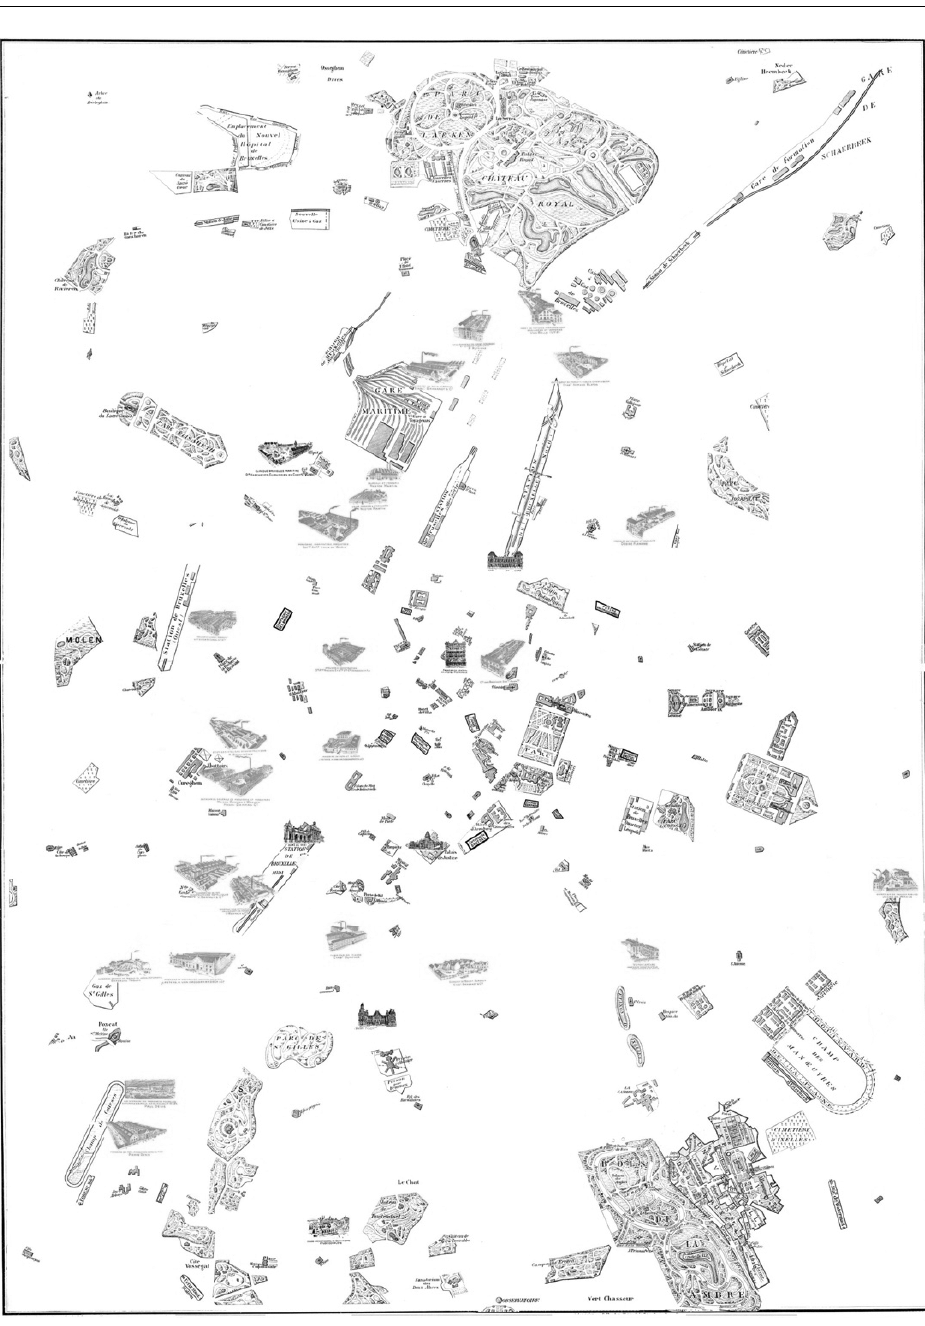
Figure 7. Extraction from the Plan Industriel (Verwest et al., 1910a, extraction made by the author). Courtesy of the Archives de la Ville de Bruxelles (plan de Bruxelles no. 130, section